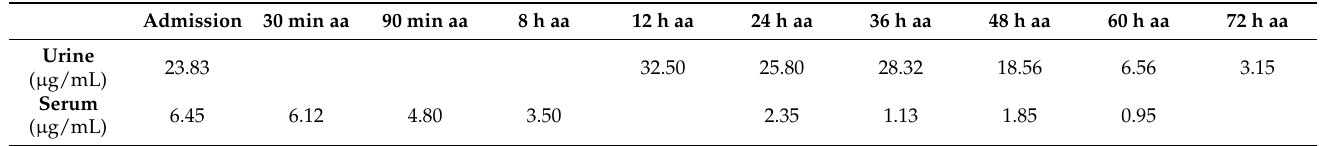
Table 1. Serum and urine time-related concentration of Quetiapine after the assumed ingestion of 28 g of Quetiapine in a 75-year-old male patient.